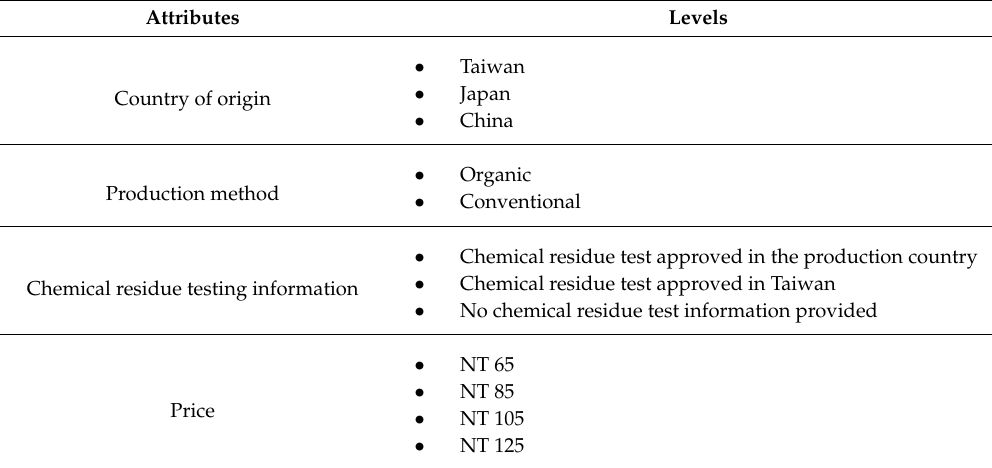
Table 1. Attributes and levels used in the Discrete Choice Experiment